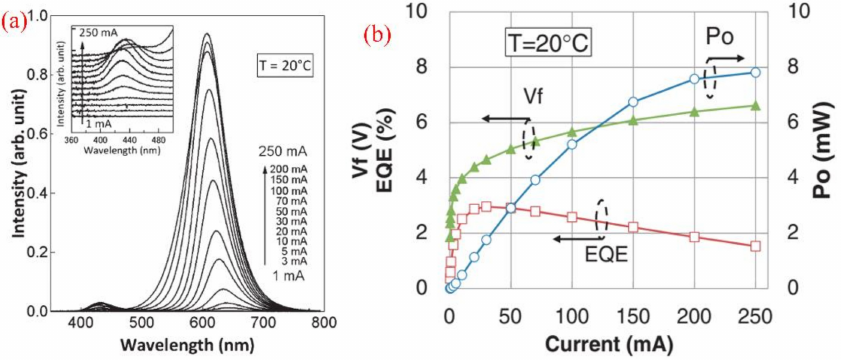
Figure 3. ( a ) EL properties of red LEDs. ( b ) Output power-current-forward voltage and EQE